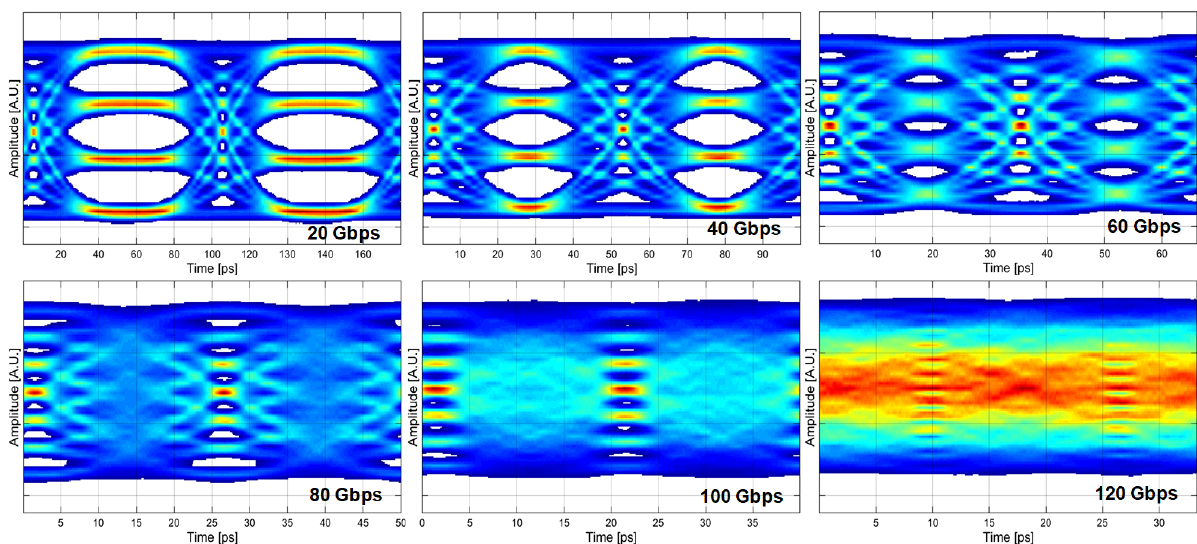
Figure 5. Received eye diagrams of PAM-4 signal for different bit rates when the high BW system (effective receiver BW of 23 GHz) in BtB configuration is